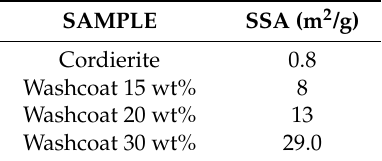
Table 1. SSA of the structured